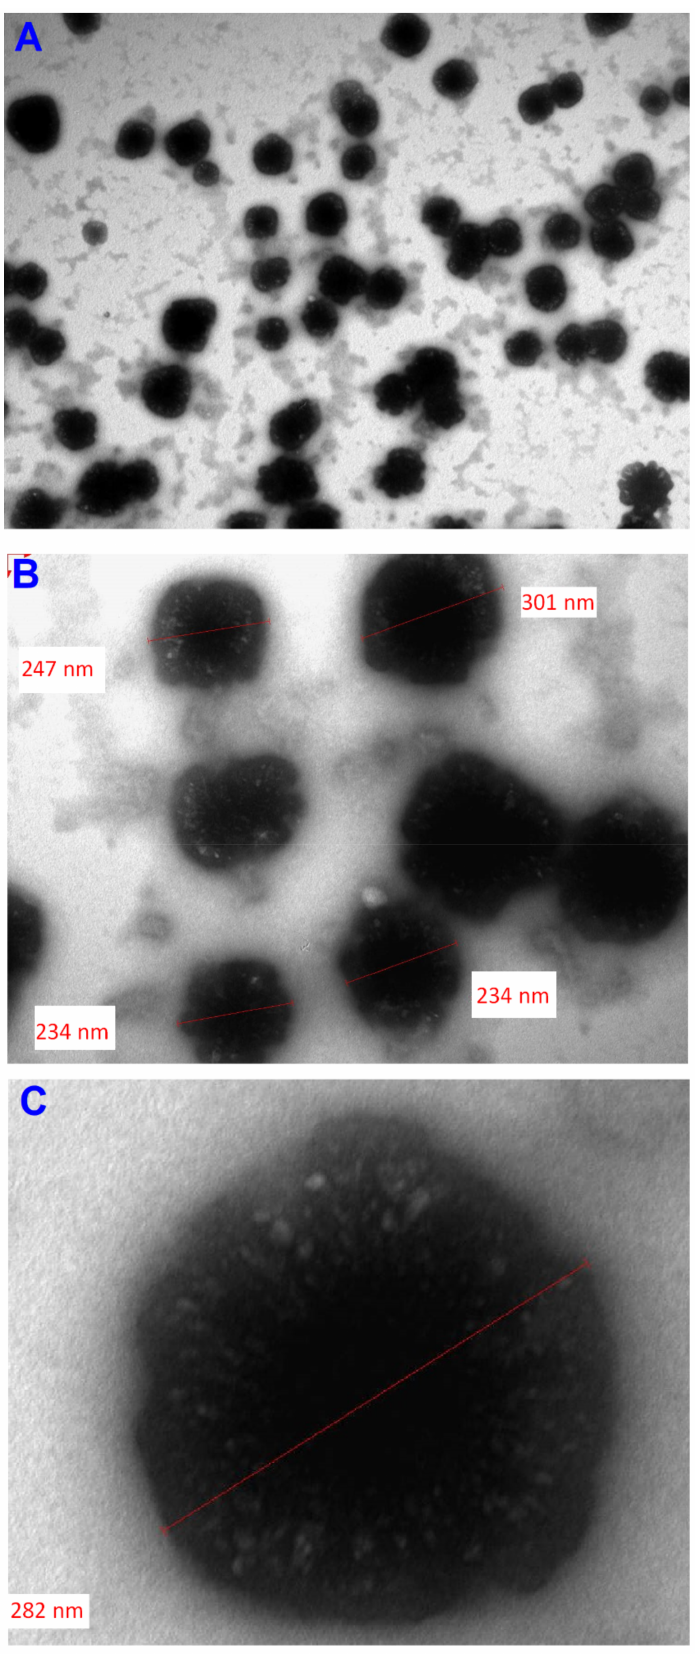
Figure 6. TEM images of (FD-SD + drug-free S-SNEDDS) at ( A ) 30,000, ( B ) 100,000 and ( C ) 200,000 ×